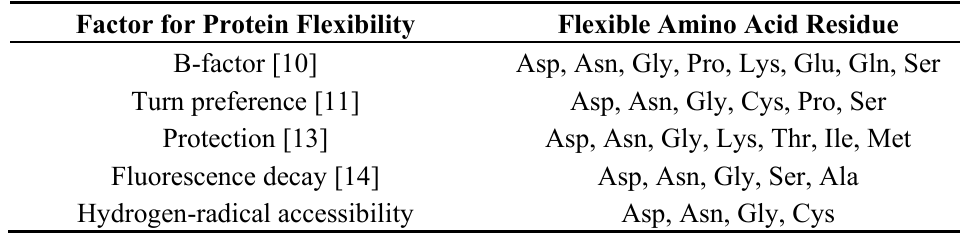
Table 2. Amino Acid Residues estimated from the B-Factor, the Turn Preference Factor, the Protection Factor, the Fluorescence Factor and the Hydrogen-Radical Accessibility Factor that represent Flexibility of